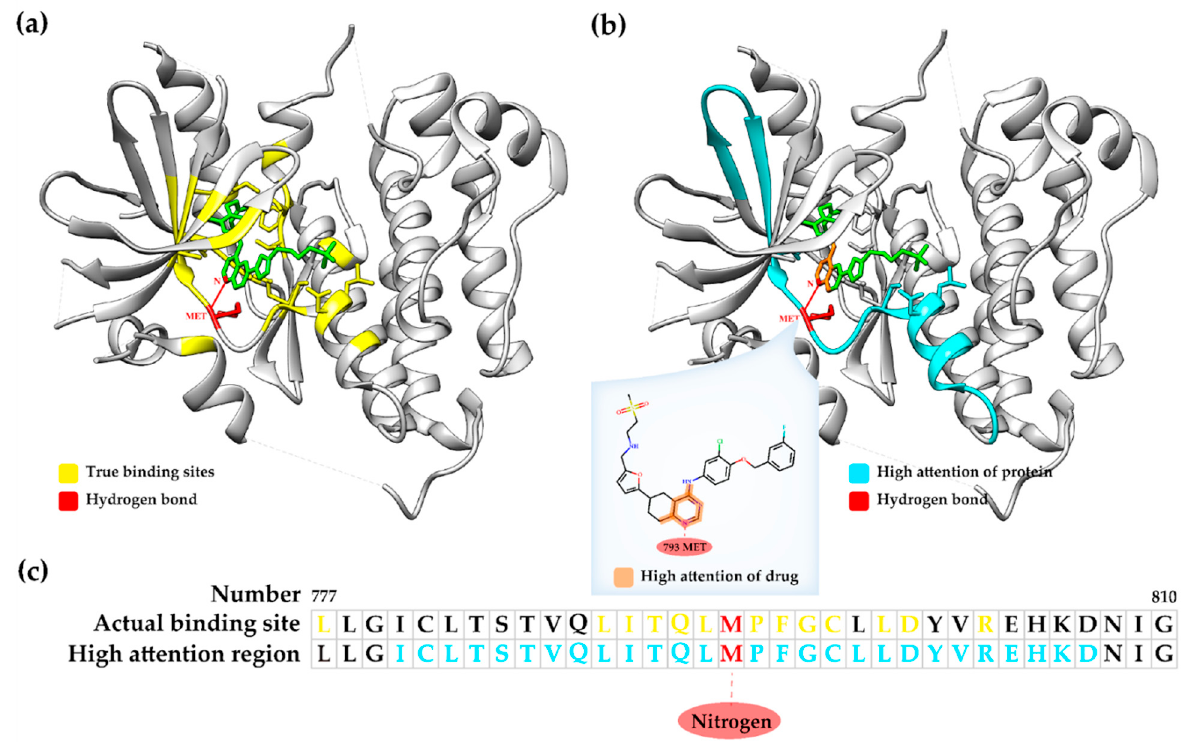
Figure 5. Visualization of drug-target binding affinities with significant regions: ( a ) complex com- pound Lapatinib and gene EGFR (PDB ID: 1XKK), where the ligand is colored green, true binding sites are yellow, the hydrogen bond is red; ( b ) complex 1XKK and visualization of substructure significance, where the high attention of drug is orange, high attention of protein is light blue; ( c ) visualization of sub-sequence significance.